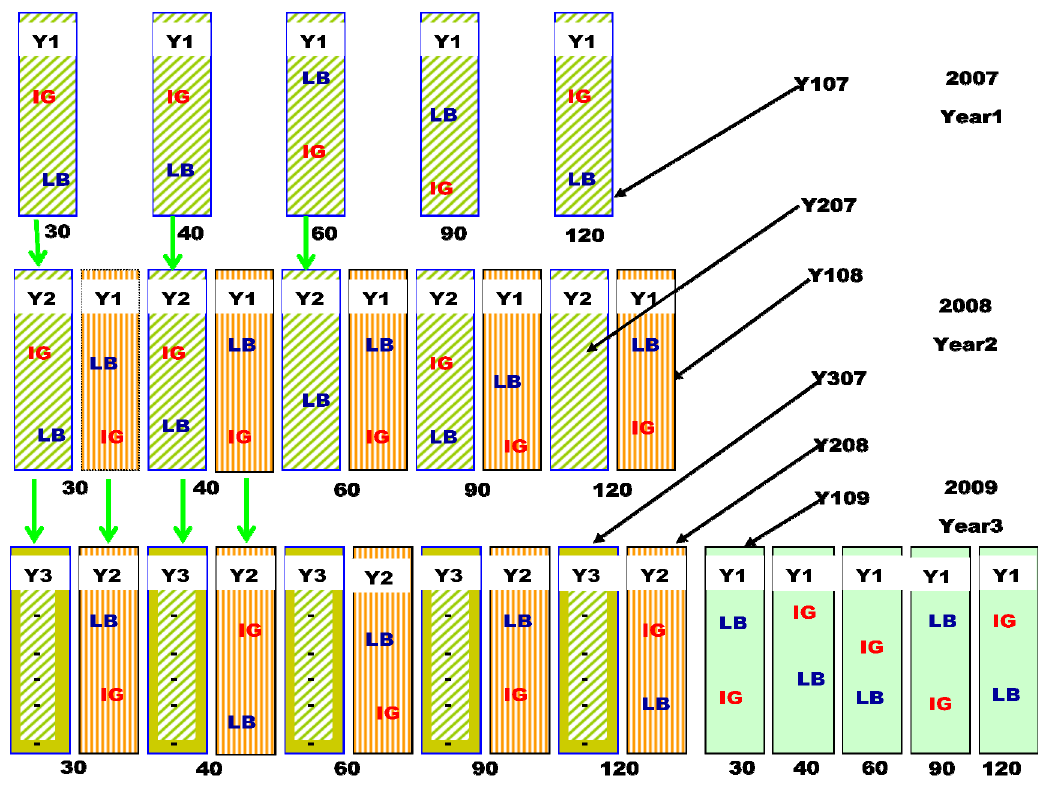
Figure 3. Plot arrangements in one of five replications, showing the establishment sequence. Five first-year plots (Y1) established in mid-May from 2007 to 2009, each 7.5 m long and 1 m wide, separated by 90-cm alleys were assigned to 30-, 40-, 60-, 90-, and 120-d harvest intervals. In each year, plots were labeled Y1, Y2, or Y3 indicating plots beginning their first, second and third harvest year, respectively. In each plot one indiangrass (IG) and one little bluestem (LB) plant was marked for monitoring yield per plant by